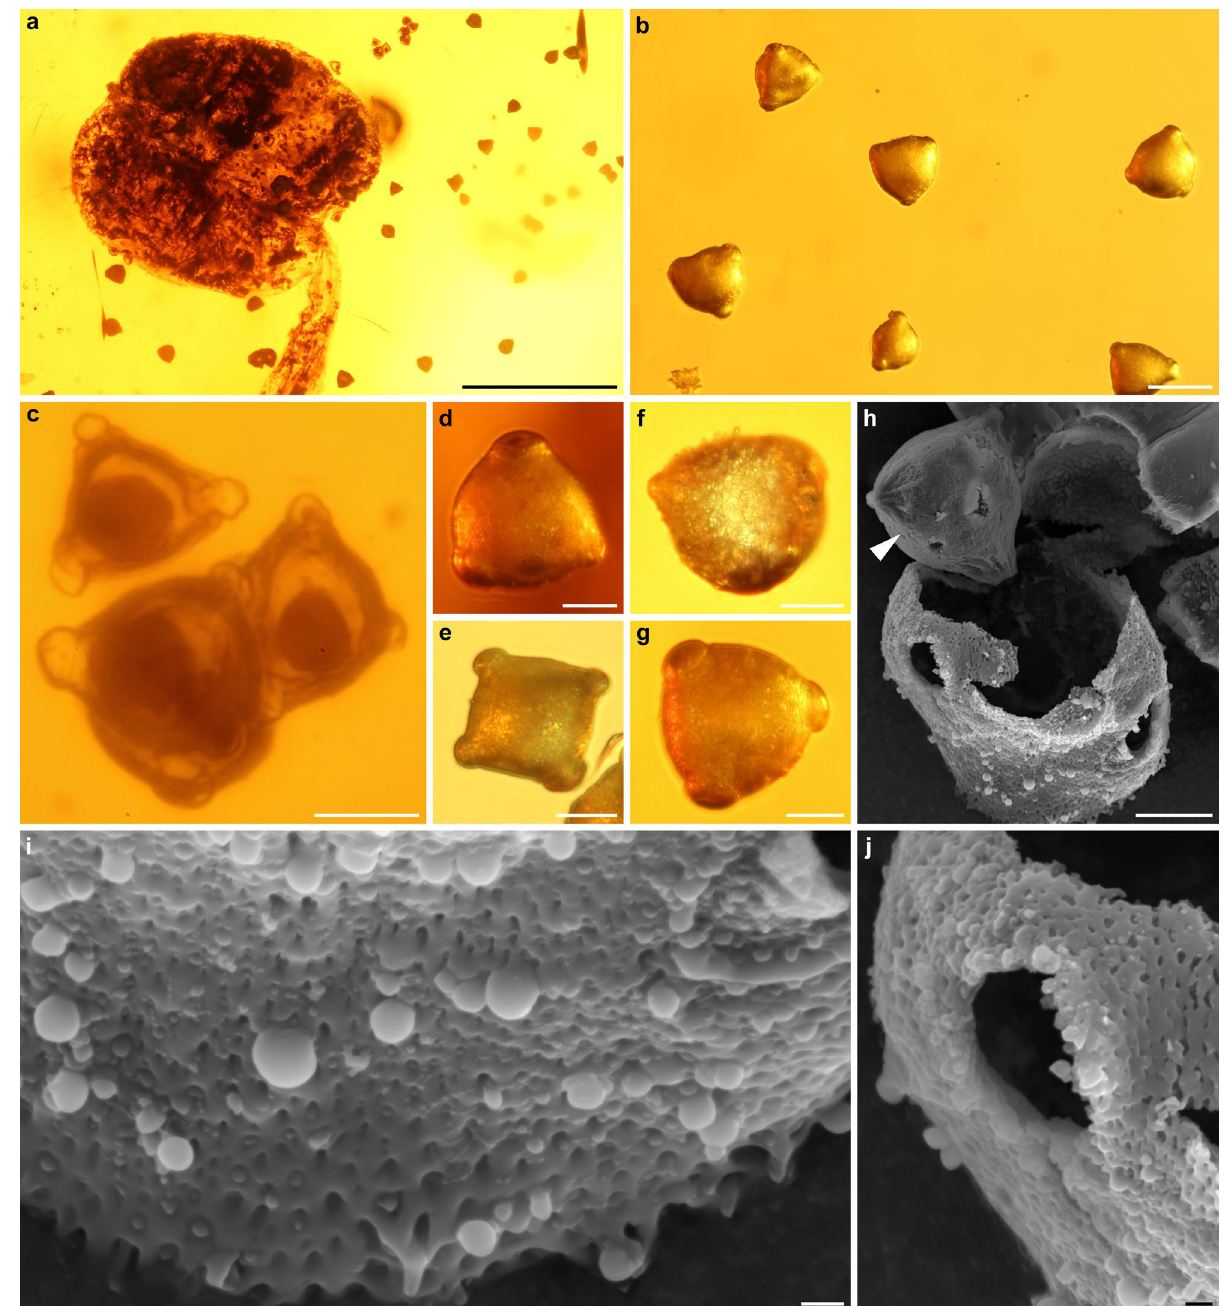
Figure 3. Pollen extracted from anthers and the surrounding amber of Symplocos kowalewskii comb. nov. et emend. (Symplocaceae; X4088) from late Eocene Baltic amber. ( a ) Anther, releasing pollen. ( b ‒ g ) Pollen under LM; note the protrusions from the apertures ( c ), which were likely caused by the excreted internal cell content. ( h ) Pollen under electron microprobe, with exposed intine (arrowhead). ( i , j ) Pollen under electron microprobe, showing perforate to microreticulate ornamentation with few supratectal blunt echini. Note the fused verrucae at the margo of the ectoaperture, forming a rim-like structure ( j ). Scale bars 500 µm in ( a ); 50 µm in ( b ); 20 µm in ( c – g ); 10 µm in ( h ), 1 µm in ( i , j